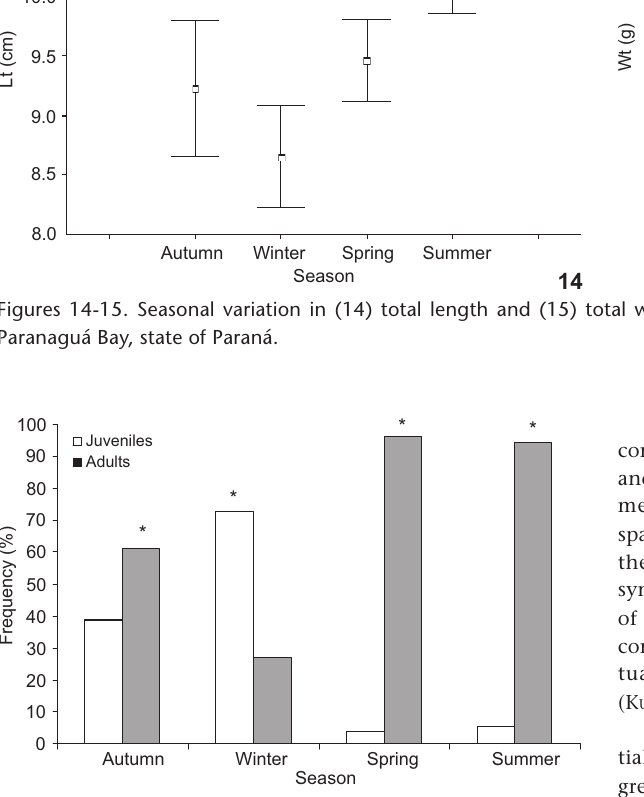
Figure 16. Seasonal ratio of juveniles to adults for the grouped sexes of A. lineatus in the Paranaguá Bay, state of Paraná. * signifi- cant values (p <